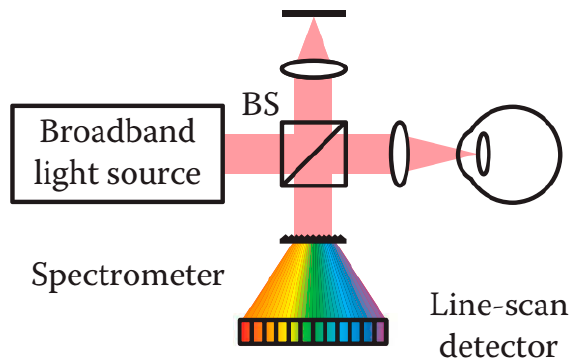
Figure 16. Schematic diagram of a spectral domain OCT (SD-OCT) system [85]. BS: Beam splitter.